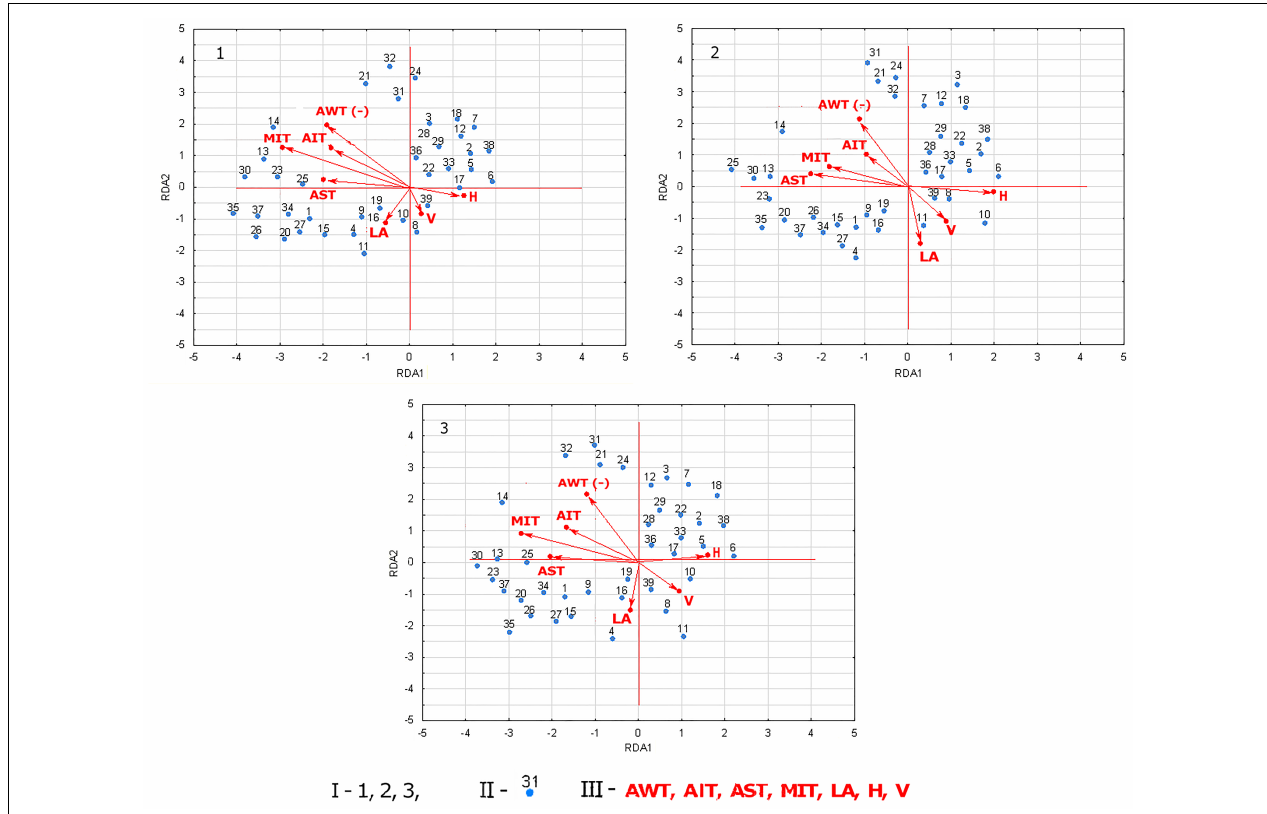
FIGURE 5 | RDA biplots illustrating relations between environmental variables and selected parameters of lake ice phenology for the water reservoirs in Silesian Upland: I–winter seasons (1–winter season 2009/2010, 2–winter season 2010/2011, 3–winter season 2011/2012); II–studied lakes (numbering as in Table 1 ); III–correlated variables (AWT, average water temperature; AIT, average ice cover thickness; AST, average snow cover thickness; MIT, maximum ice cover thickness; LA, reservoir surface; H, average reservoir depth; V, reservoir volume